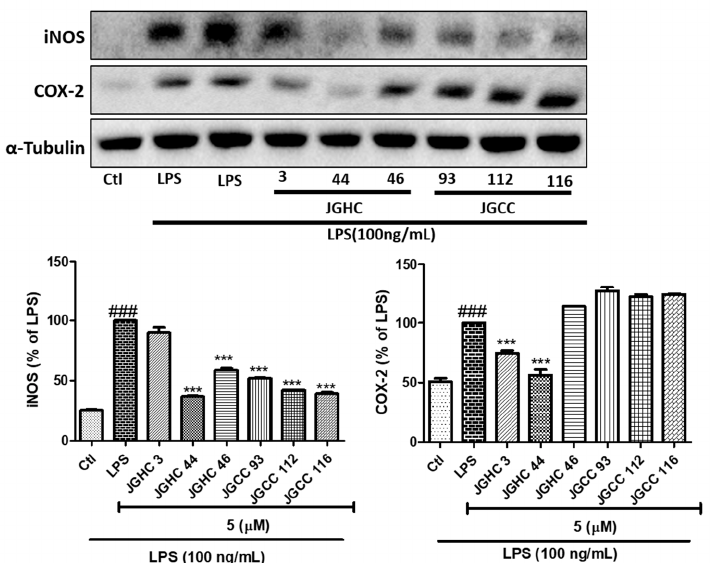
Figure 4. Active components from A. holophylla subfractions inhibited expression of inducible nitric oxide synthase (iNOS) and cyclooxygenase (COX-2) in LPS-activated microglia. Western blot analysis of BV2 cells pre-treated with the JHC 3, JGHCC 44, JGHC 46, JGCC 93, JGCC 112, and JGCC 116 subfractions and activated with LPS. Expression and quantification of iNOS and COX-2 against LPS-activated microglia. *** p < 0.001 indicates significant differences compared with treatment of LPS alone, while ### p < 0.001 indicates significant differences compared with the untreated control group. Ctl indicates untreated control cells, LPS indicates LPS-treated cells.